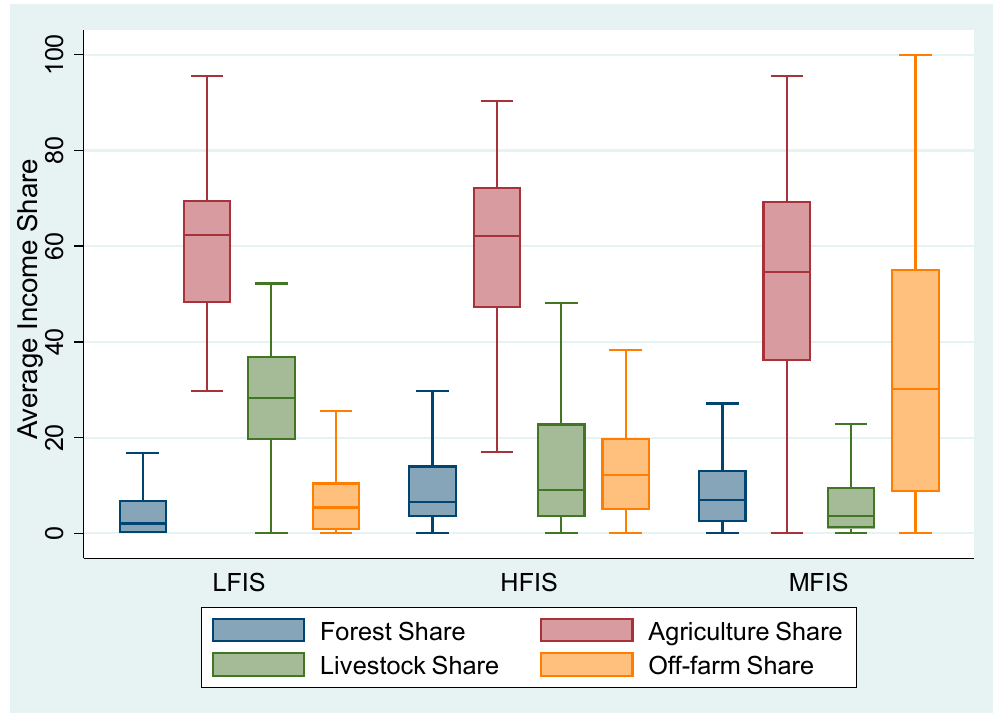
Figure 3. Average Income Share by typology. Note: LFIS = Low Forest Income Share, HFIS = High Forest Income Share, and MFIS = Medium Forest Income Share.